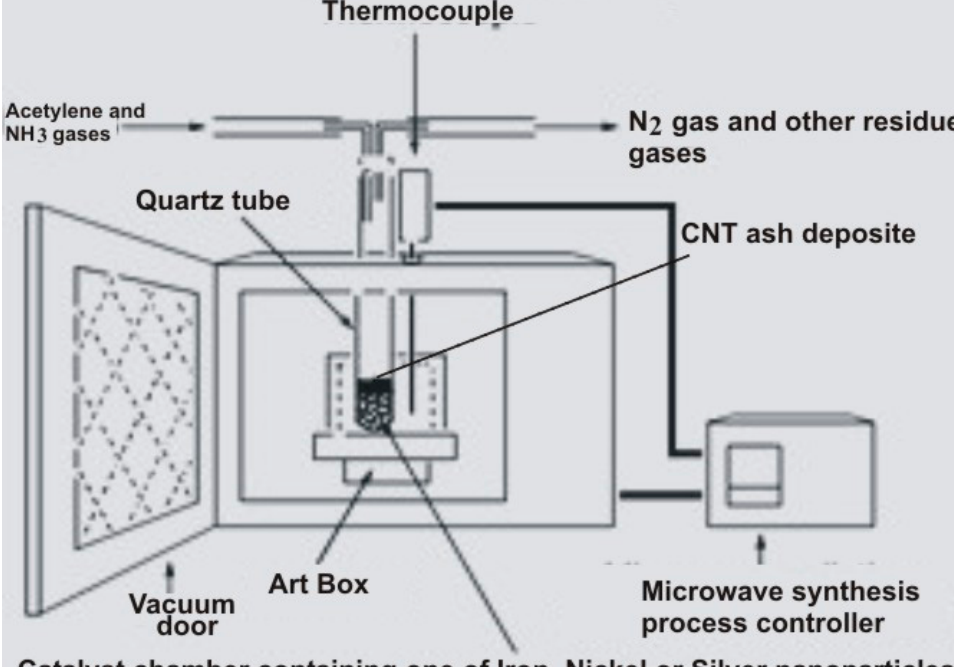
Figure 2. The sketch of the experimental setup used for the synthesis of CNTs by microwave heating. NH 3 /Ar and B 2 O 3 were used to remove some residues of oxide [15]. The washed samples were then dried at 80 ◦ C. The reaction temperature was 300 ◦ C. Argon was used because chemically inert materials prevent all other unwanted reactions during the